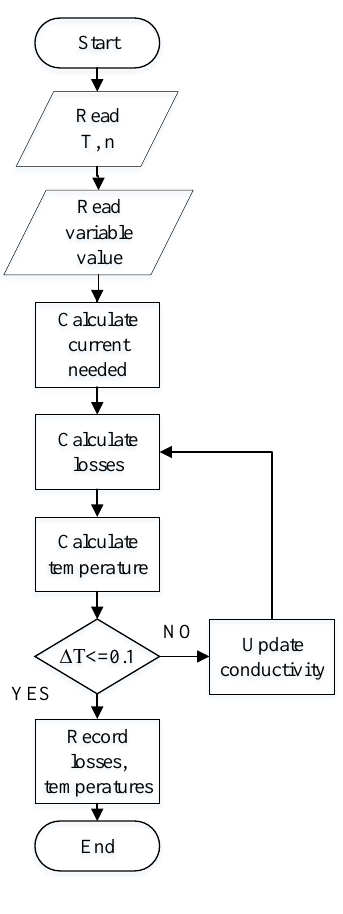
Figure 5. The calculations flow chart.